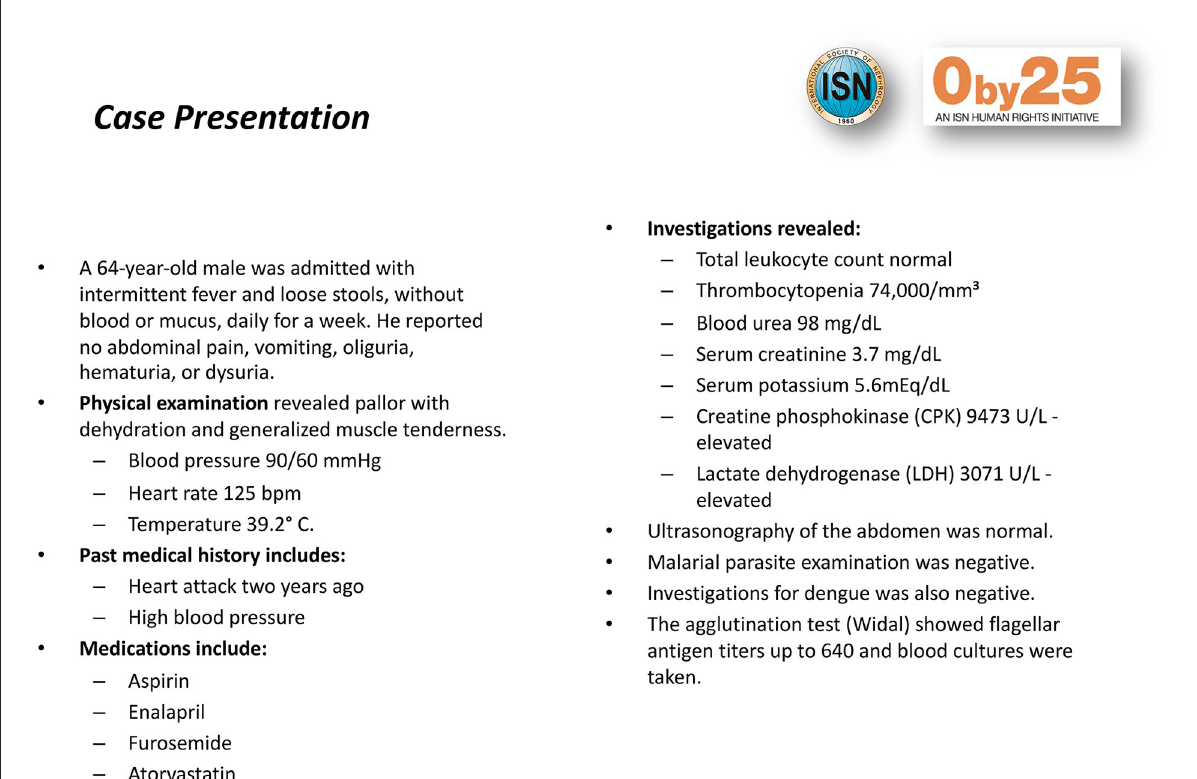
FIGURE2 Clinical vignettes. Example of one of the clinical vignettes prepared for the study.